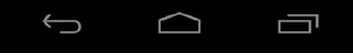
Fig. 10 The localization result shown in mobile